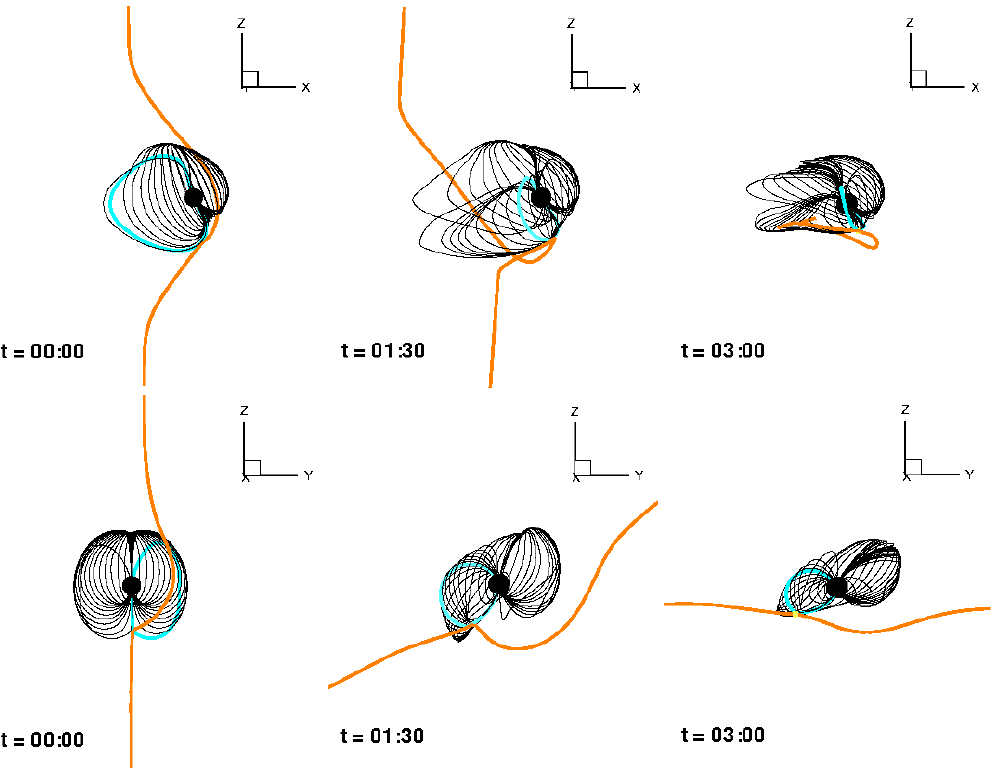
Fig. 10. The site of merging between the IMF (yellow line) and the earth’s magnetic field (blue line) for three UT times. Only the closed field lines of the Earth are shown. The upper row is seen from the dawnside and the bottom from the sun.